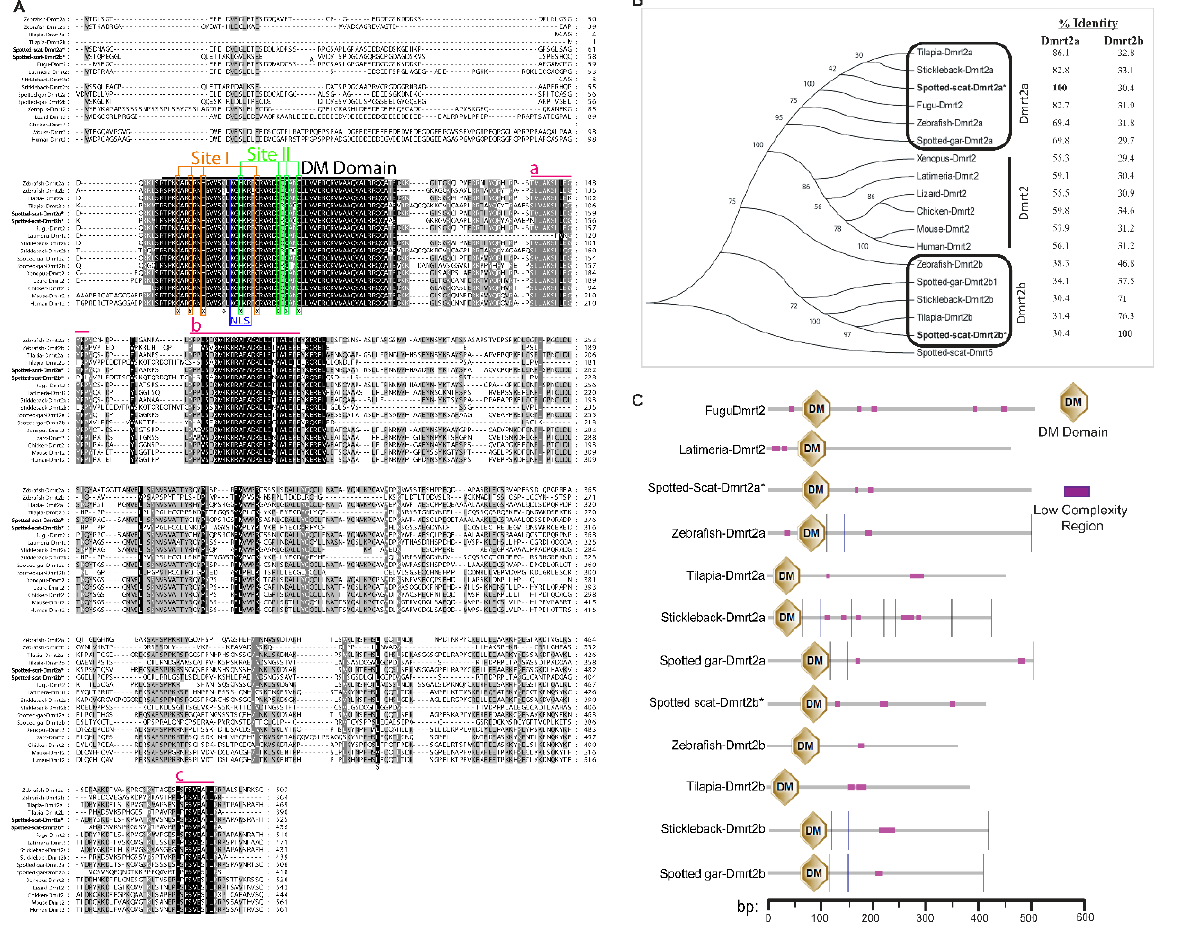
Figure 2. Homologous comparison of spotted scat Dmrt2a and Dmrt2b amino acid (aa) sequences with other species. ( A ) Alignment of Dmrt2a and Dmrt2b (aa) from different species. Amino acid (aa) sequences are numbered to the right. The dark overline indicates the conserved DM domain region. The two intertwined zinc-binding sites, site I (CCHC) and II (HCCC), are shown. The putative nuclear localization signal NLS is indicated. Red over lines numbered a, b, and c are other Dmrt2 conserved regions. Asterisk indicates the conserved cysteine and histidine residues. ( B ) Phylogenetic analysis of Dmrt2 proteins from different species based on outgroup of spotted scat Dmrt5. The neighbor-joining method of MEGA 6 was used to develop the tree. Numbers on nodes indicate the credibility of the branches using 1000 bootstrap replicates. Asterisks indicate cloned spotted scat Dmrt2a and Dmrt2b and clustered among their counterparts. The identities of spotted scat Dmrt2a and Dmrt2b amino acid sequences with other spices are shown on the right side. ( C ) Schematic representation of Dmrt2 domain features of different species predicted by SMART (http://smart.embl-heidelberg.de/, accessed on 17 October 2021). The scale bar indicates the length of amino acids (aa) in base pairs (bp). The hexagons indicate DM domain regions. The accession numbers of the sequences used are described in Table S2. 3.2. The Dmrt2a Genomic Sequence in Female and Male Spotted Scat Is Dissimilar Genotypic and phenotypic sex identification of spotted scat was carried out as described in [3] before subsequent use for other analysis. The initial analysis of the genomic sequence of male and female spotted scat revealed some dissimilarities. The information regarding the genomic sequence data was previously published by our group [32]. Further gDNA cloning and sequence analysis from 3 males and 3 females revealed dispersed insertions and deletions (indels) in introns 1 and 2 (Figure 3). However, the gene structures of spotted scat Dmrt2a and Dmrt2b are comparable to other species, except that the intron 1 of Dmrt2a is more extended (2040 bp) than that of other species, with the closest being zebrafish with 1720 bp. The vast difference between the intron 1 of spotted scat and other species is probably due to the numerous indels (Figure 3). In addition, three SNPs, one on exon 2 (I) and two on intron 2 (II and III), were also found. However, the